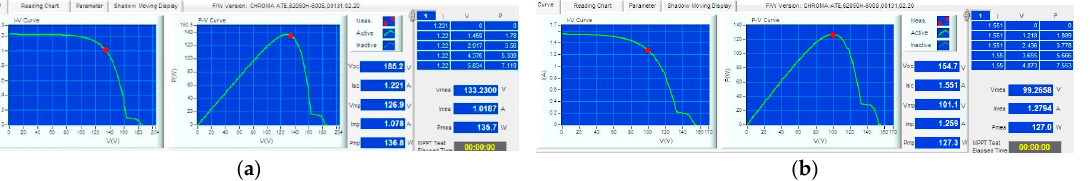
Figure 12. The tracking point of I-V and P-V curves under partial shading ( a ) condition 1, ( b ) condition 2.